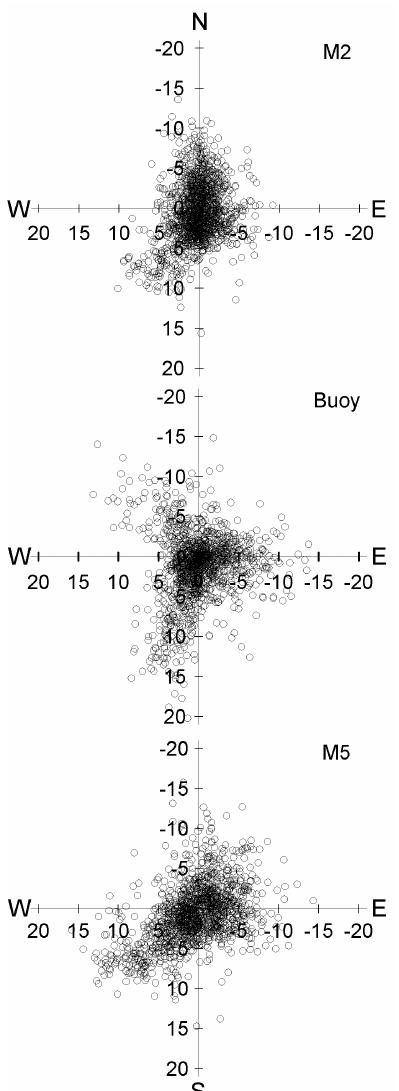
Fig. 12. Polar plots of wind data measured from the buoy and pre- dicted by the model in the M2 and M5 grid